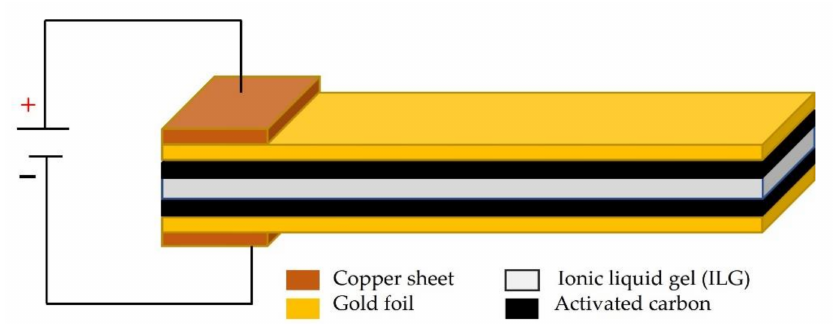
Figure 4. IPMC with a five-layer structure. Redrawn from [30].